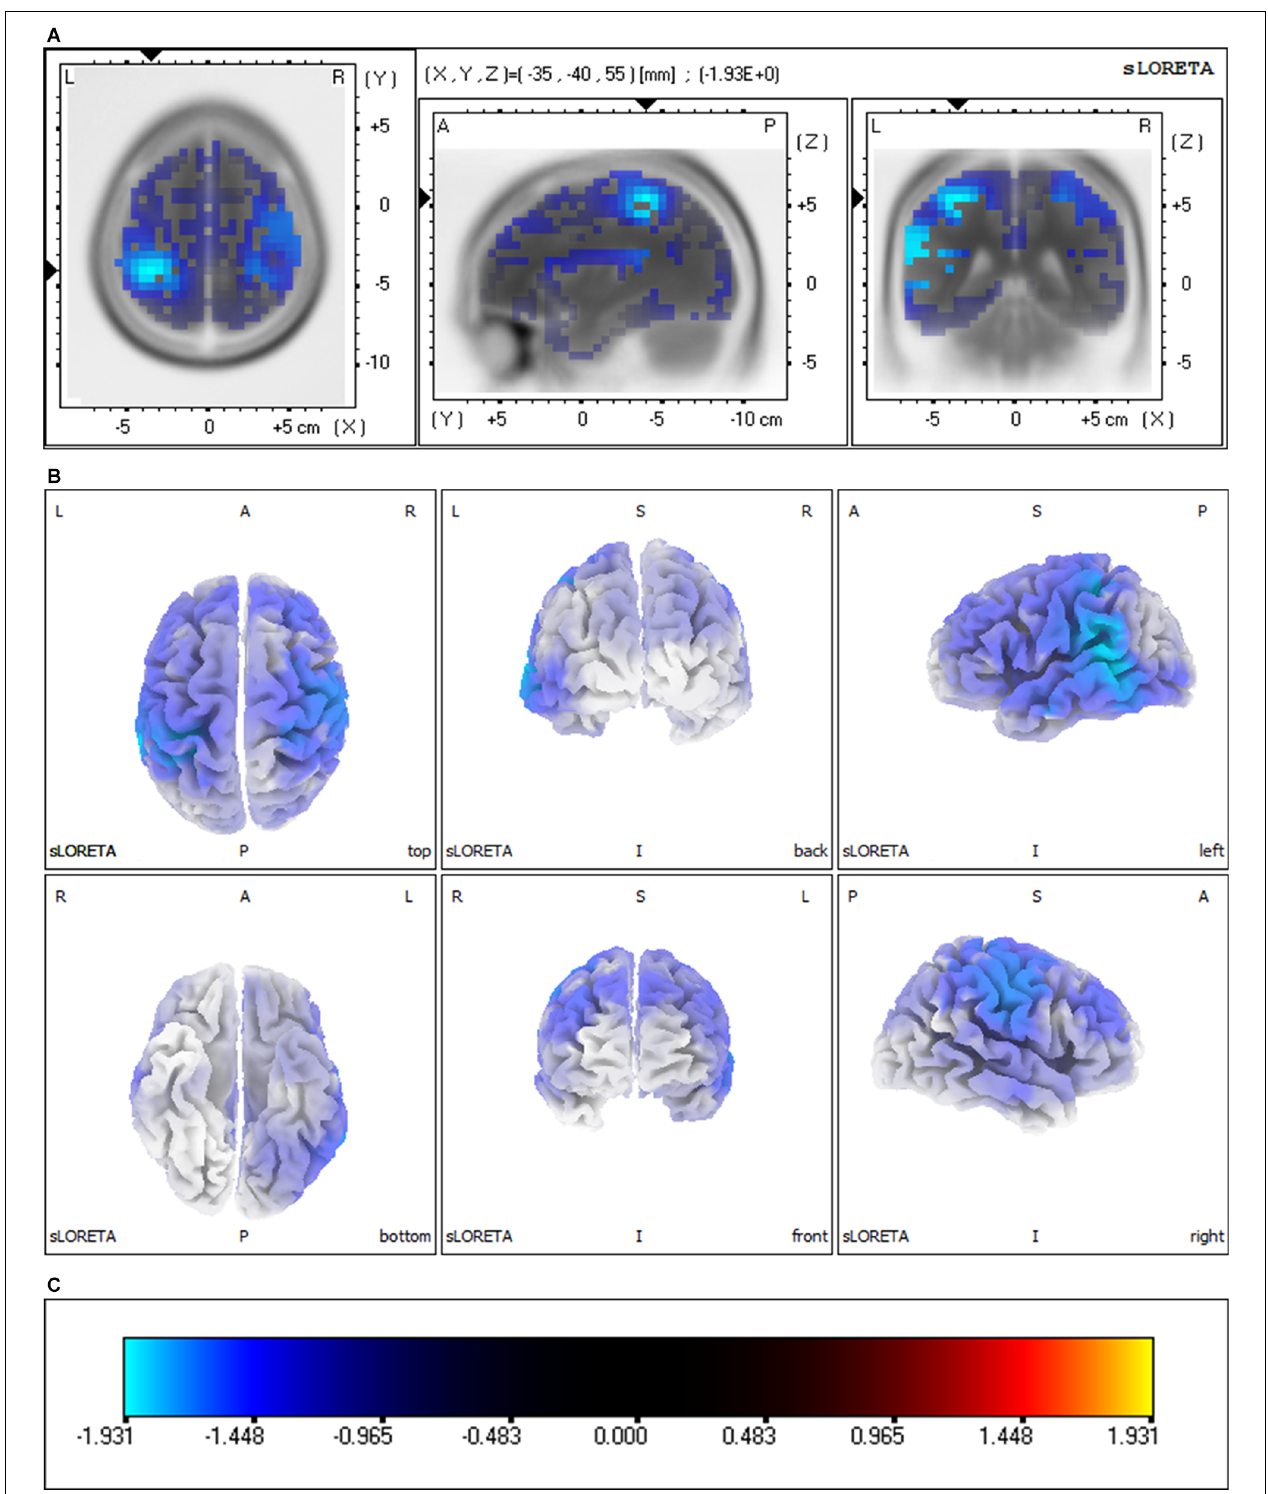
FIGURE 3 | Significant group comparisons of the sLORETA source imaging between the VM and HC groups. Regions with significant differences between groups are shown in three MRI views of the head (A) and 3D brain map views (B) . The color scale (C) represents log-F ratio values (threshold: log-F = 0.836, p < 0.01, two-tailed). The difference in current density maximum was highest in the postcentral gyrus of the parietal lobe [MNI coordinates (x, y, z = − 35, − 40, 55), BA 40; logF = − 1.93, p < 0.001]. L, left; R, right; A, anterior; P, posterior; BA, Brodmann area.